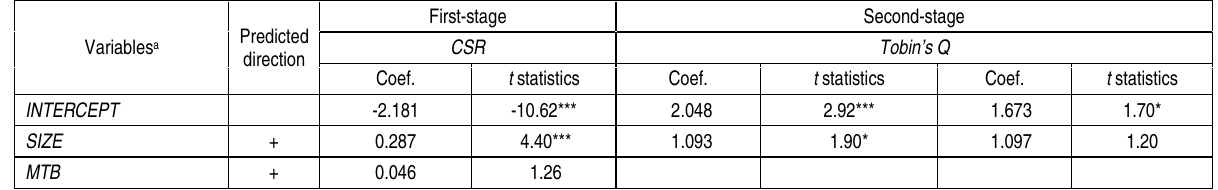
Table 5. The association between CSR engagement and firm performance － Heckman two